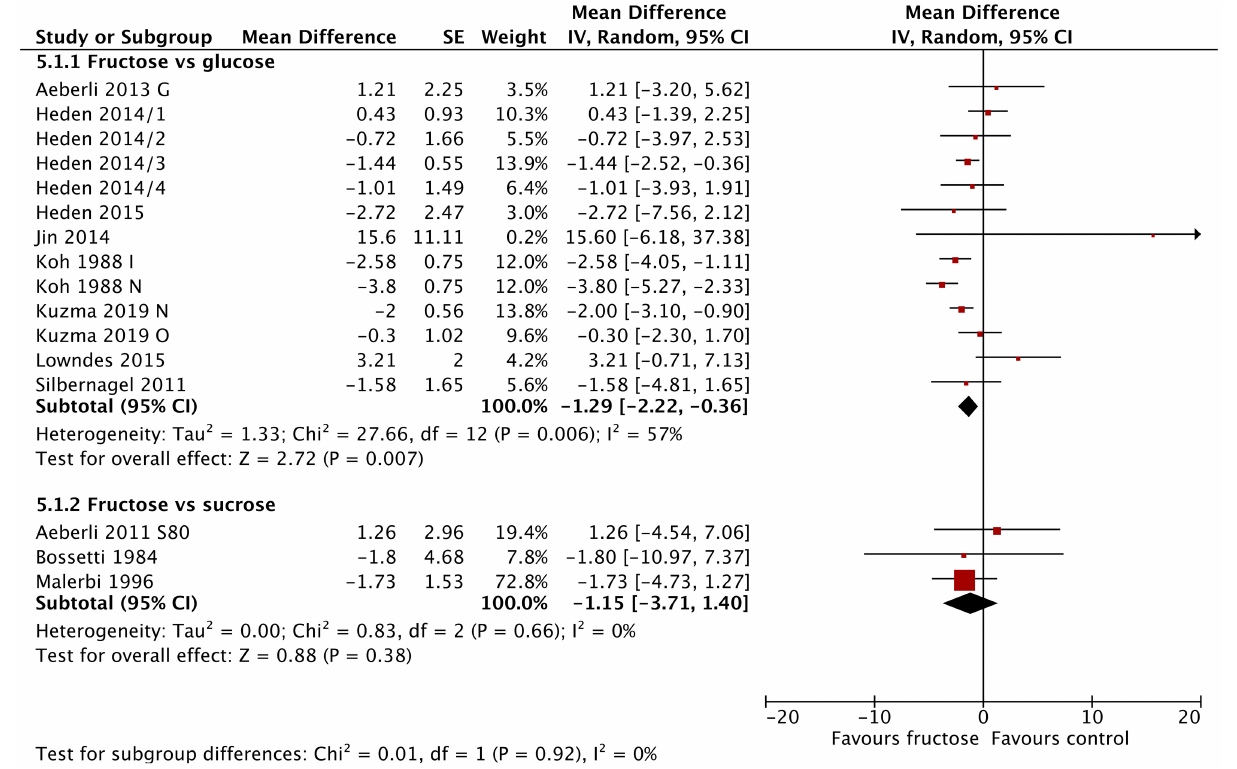
( Supplementary Table 1 ). Unclear blinding, age of